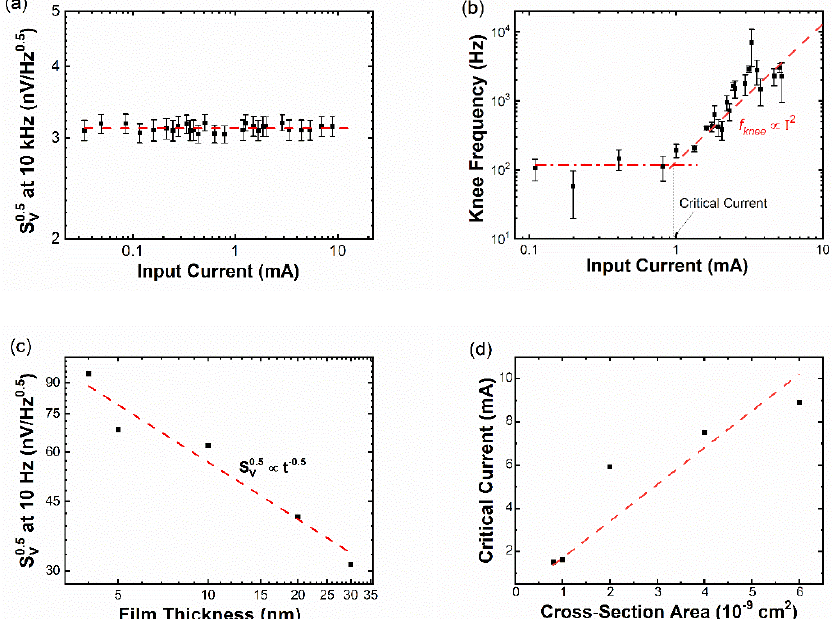
Figure 3. ( a ) High-frequency noise of the 20 nm thick Fe 29 Pt 71 sample under various input currents. The red dashed line shows the theoretical prediction of Johnson noise √4𝑘 𝐵 𝑅𝑇 . ( b ) Knee frequency of the Fe 29 Pt 71 sample under various input currents. Above critical current (~1 mA), knee frequency increases quadratically with input current. ( c ) Low-frequency noise of the Fe 29 Pt 71 sample with different thicknesses. Input current is kept below critical current. The red dashed line shows the linear fitting in the log–log plot, which gives 𝑆 𝑣1/2 ~𝑡 −0.5 . ( d ) Critical current of the Fe 29 Pt 71 sample with different cross-section areas (width of the Hall bar is 20 𝜇𝑚 ). The slope of the red dashed line gives the critical current density of 1.7 × 10 6 𝐴/𝑐𝑚 2 .